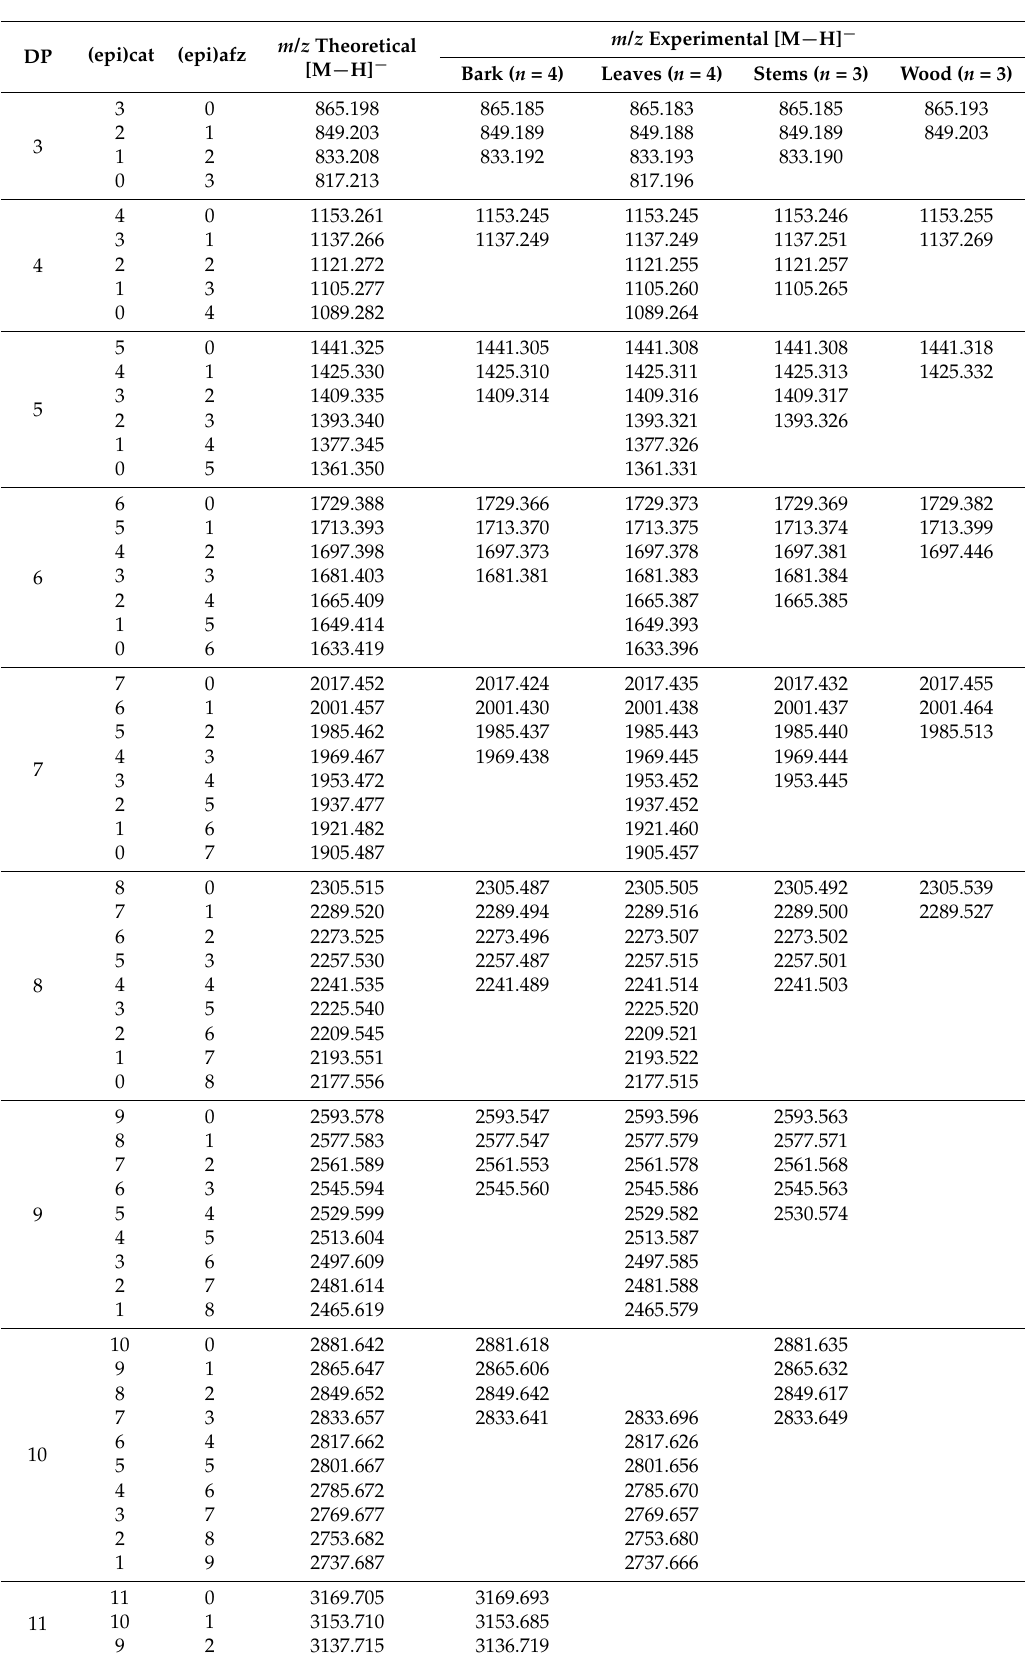
Table 2. Proanthocyanidin characterization of U. tomentosa extracts by DI-ESI-QTOF